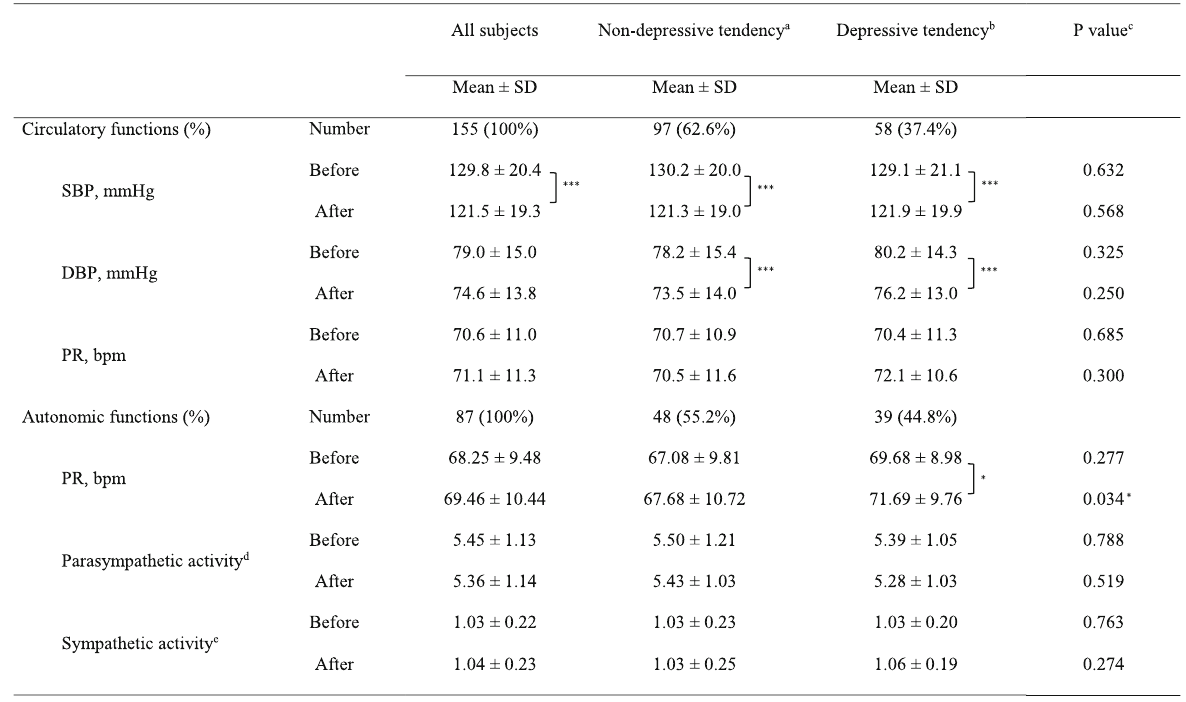
Table 2 Changes of circulatory functions and autonomic functions by Forest bathing in the subjects with and without depressive